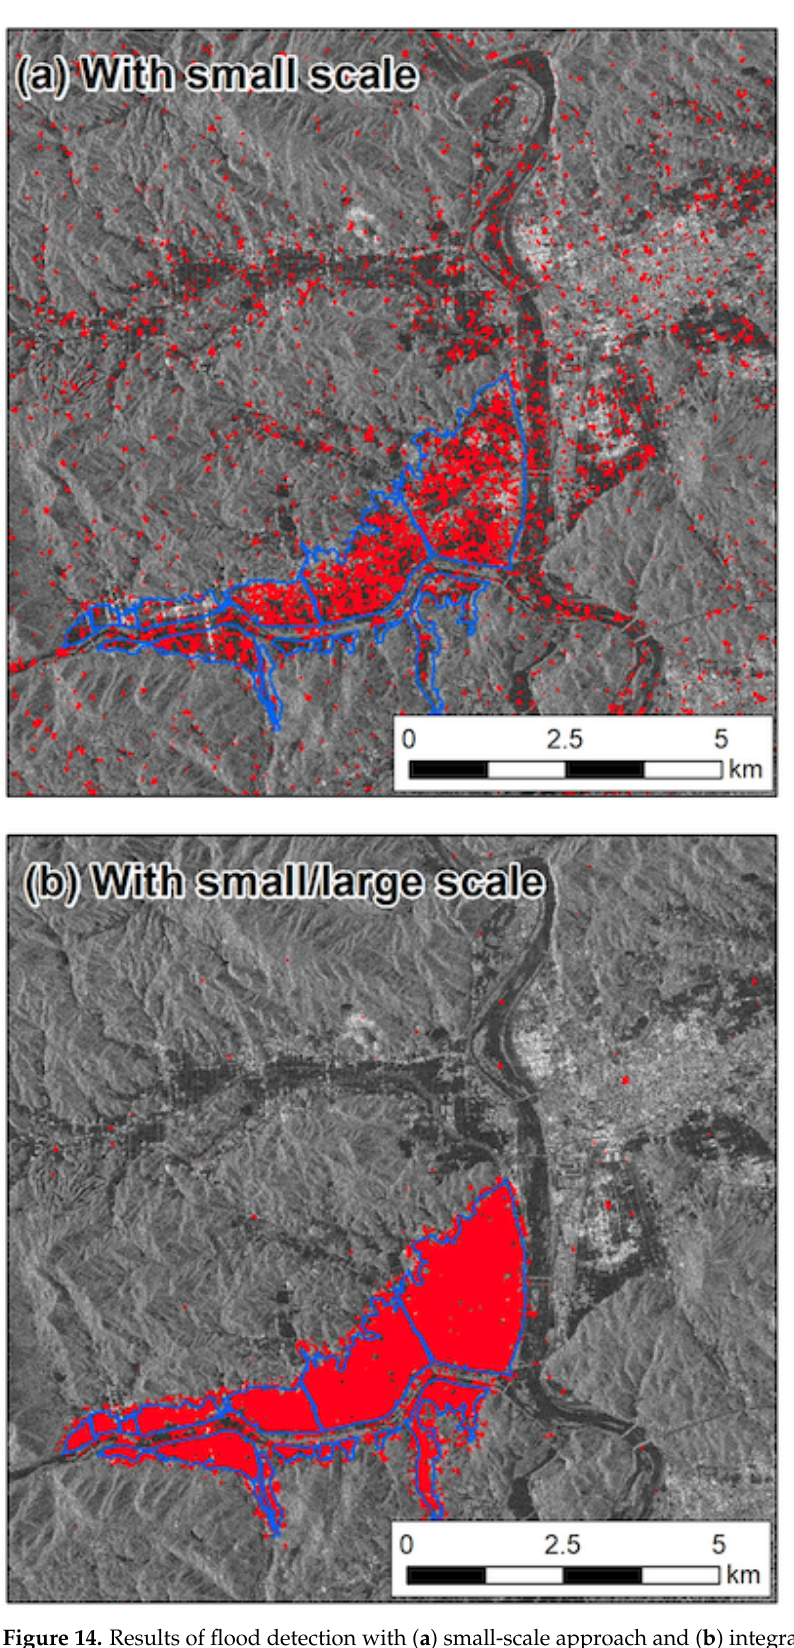
Figure 14. Results of flood detection with ( a ) small-scale approach and ( b ) integrated approach using both small and large